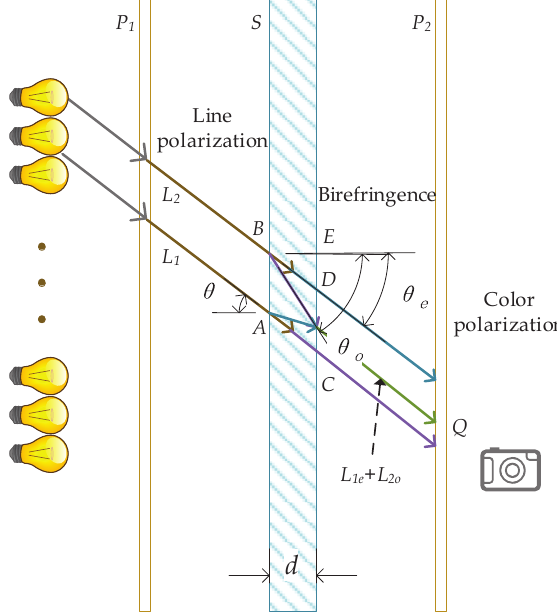
Figure 1. Illustration of optical ray. The birefringent plate S is placed between the polarizing plate P 1 and P 2 . As light passes through, this group of units produces a color polarization